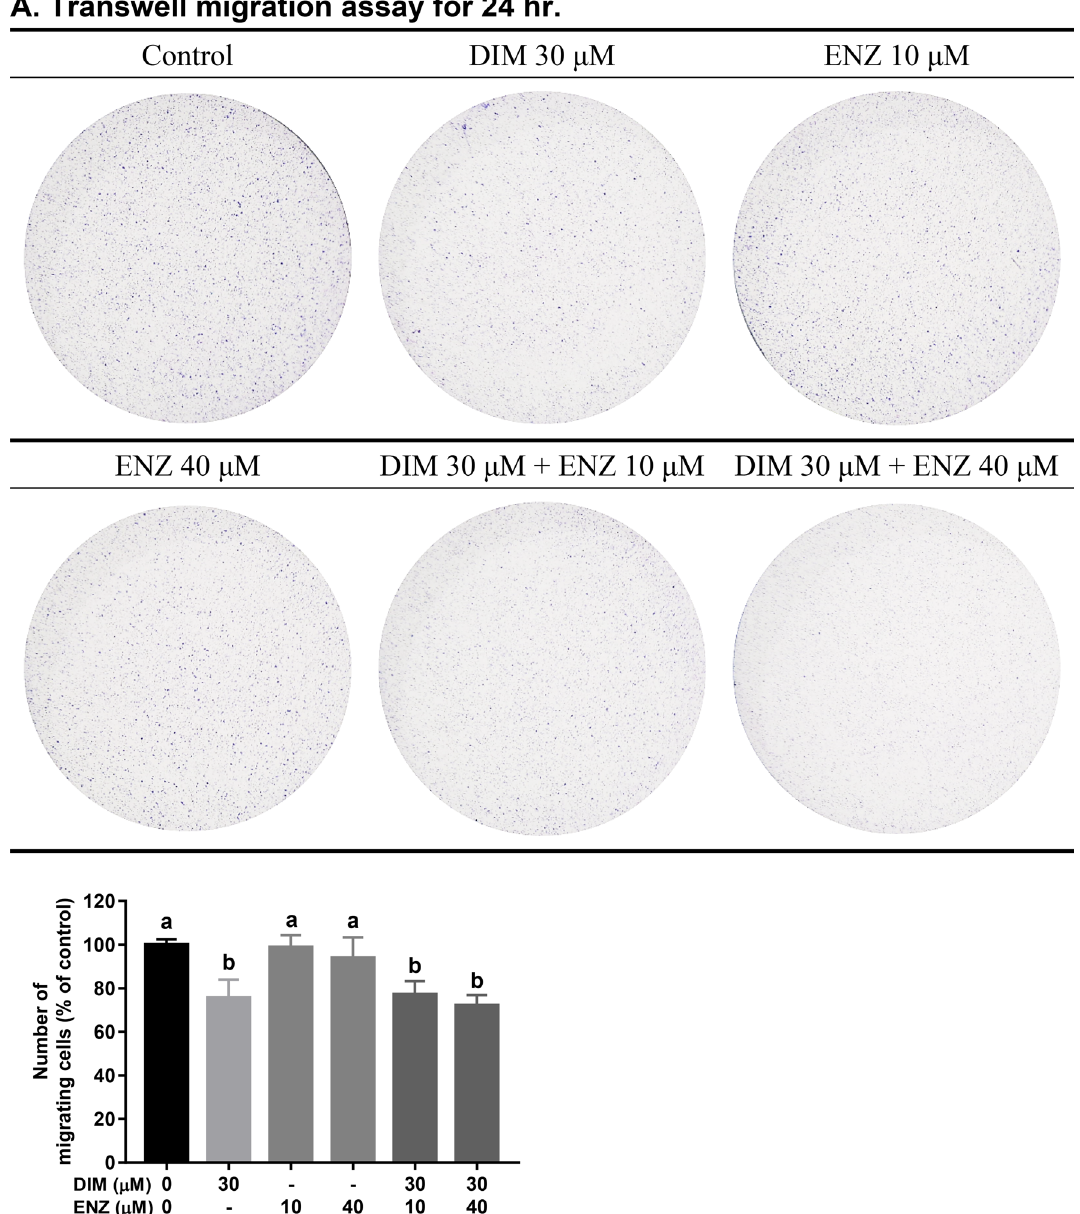
Figure 3. DIM potentiates the inhibition effect of ENZ on PCa cell invasion (n = 3). DIM 3,3 ′ -diindolylmethane; ENZ enzalutamide. Results of cell migration ( A ) and invasion ( B ) assays. Values are presented as means ± SD. a,b,c Bars without the same letters at the top indicate statistically-significant differences between treatments when compared with each other (one-way ANOVA, Duncan’s new multiple range test, p <